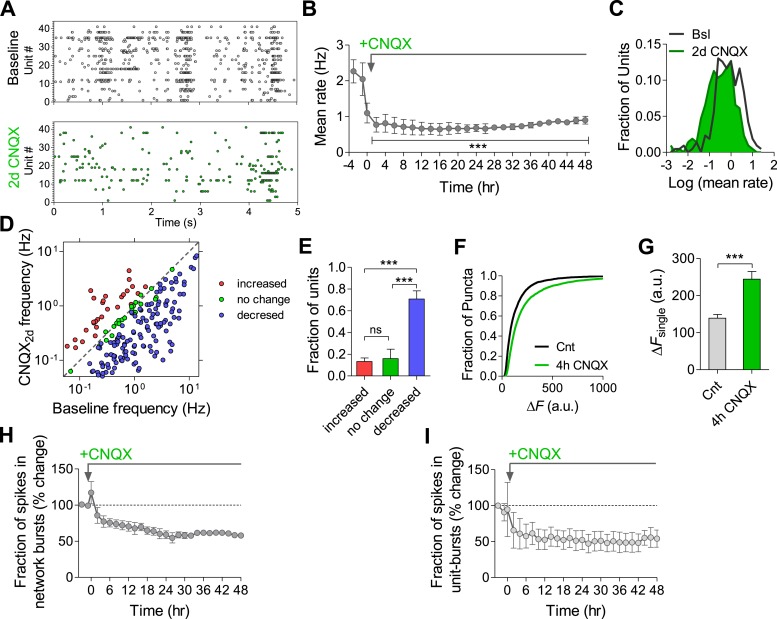
Effects of chronic AMPAR blockade on spontaneous network firing.(A) Representative raster plot of MEA recording before and 2 days after application of CNQX. (B) Changes in mean firing rate following 10 µM CNQX application utilizing MEA recordings (n = 4). 3 hr of baseline rates are shown. There is an immediate and prolonged reduction of firing rate (p < 0.001 for all hours compared to baseline; one-way ANOVA with Bonferroni's multiple comparison test). For clarity, only every other hour is shown. Error bars represent SEM. (C) Distribution of unit firing rates (log scale) during baseline and after 2 days in the presence of CNQX. (D) Per unit correlation between baseline firing rates and firing rates after 2 days in the presence of CNQX (n = 4, 128 units). Colors represent units that significantly increased (red), decreased (blue), or remained stable (green) as determined by bootstrapping (see ‘Materials and methods’ for details). Note log scale of both axes. (E) Summary of data in (D). ***p < 0.001; one-way ANOVA with Tukey's multiple comparison test. (F) Cumulative histogram of fluorescence intensity of FM1-43 stained puncta following 30 stimuli given at 1 Hz (ΔFsingle control, n = 9, 3631 puncta; 2 days CNQX, n = 9, 5251 puncta). (G) Summary of mean ΔFsingle from (F). Mean ΔFsingle is increased already after 4 hr of incubation with baclofen and remains high after 2 days of baclofen incubation. ***p < 0.001; one-way ANOVA with Tukey's multiple comparison test. (H) Normalized fraction of spikes in network bursts (the same experiments as in B). There was a significant reduction from the fourth hour onward (p < 0.001; repeated-measures ANOVA with Bonferroni's multiple comparison test). (I) Normalized fraction of spikes in single-unit bursts (the same experiments as in B). There was a significant reduction from the sixth hour onward (hours 6–10, p < 0.05; hours 12–36, p < 0.01; hours 36–48, p < 0.001; repeated-measures ANOVA with Bonferroni's multiple comparison test). Error bars represent SEM.